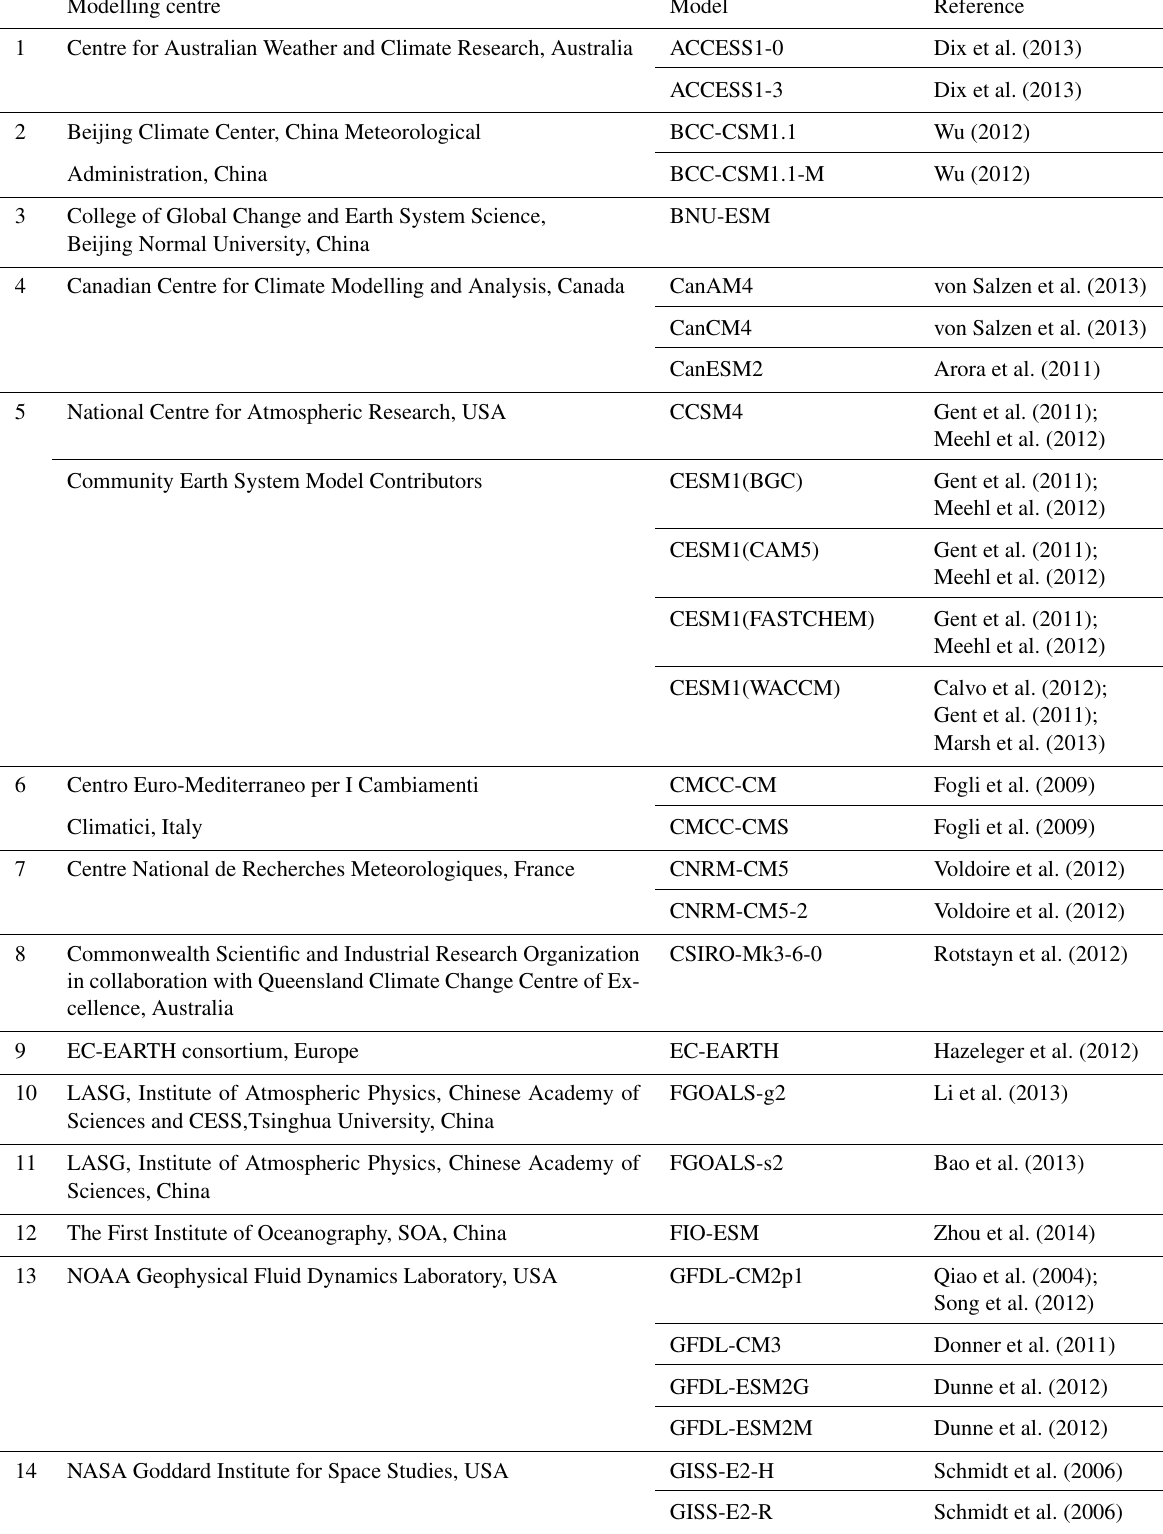
Table 2. Overview of CMIP5 models used in the figures shown in this paper alongside with a reference. Modelling centre